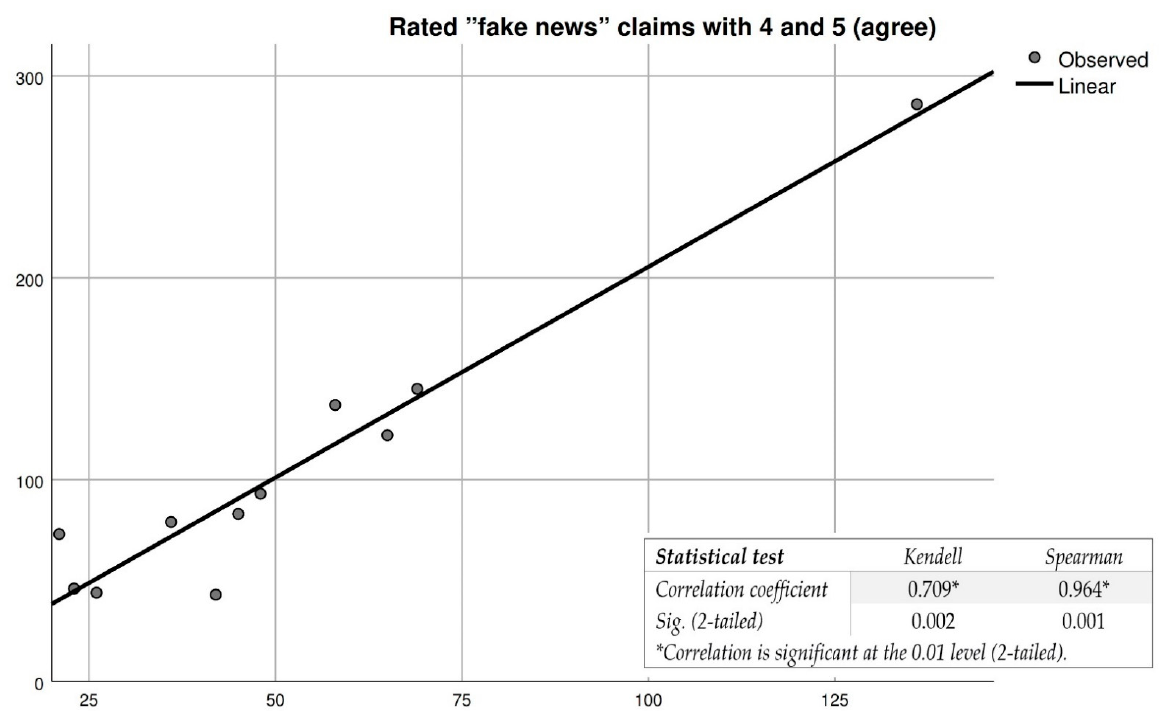
Figure 4. Correlation between participants’ trust in “fake news” information and their decision